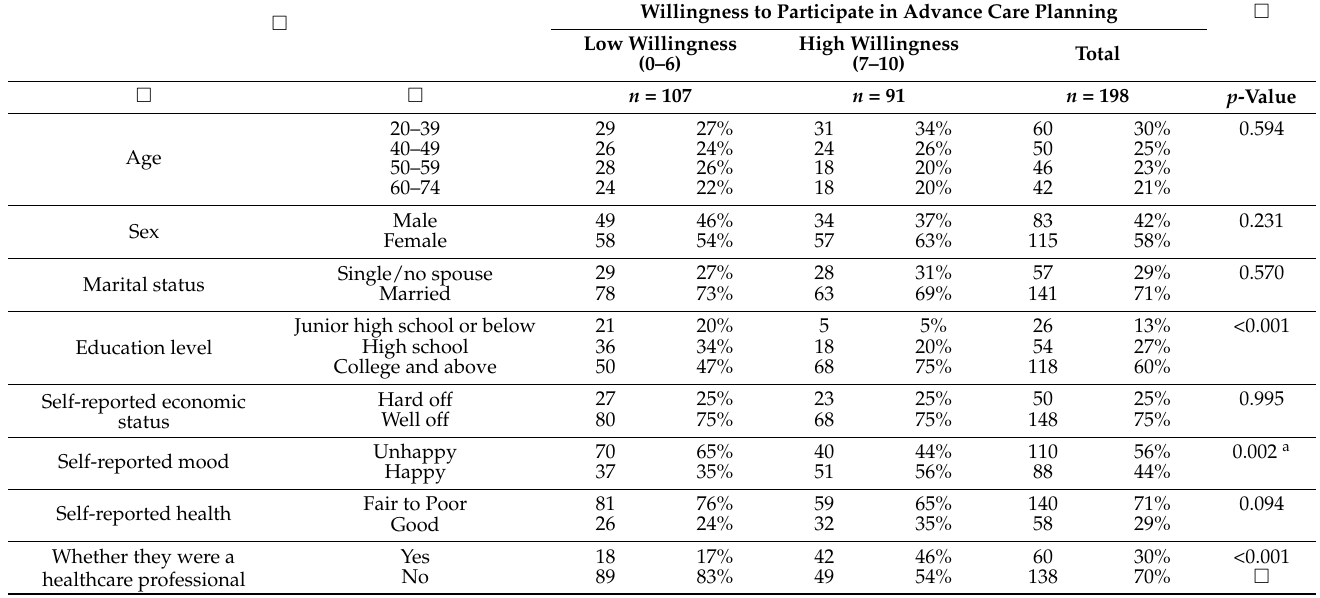
Table 1. General characteristics of respondents ( n = 198).